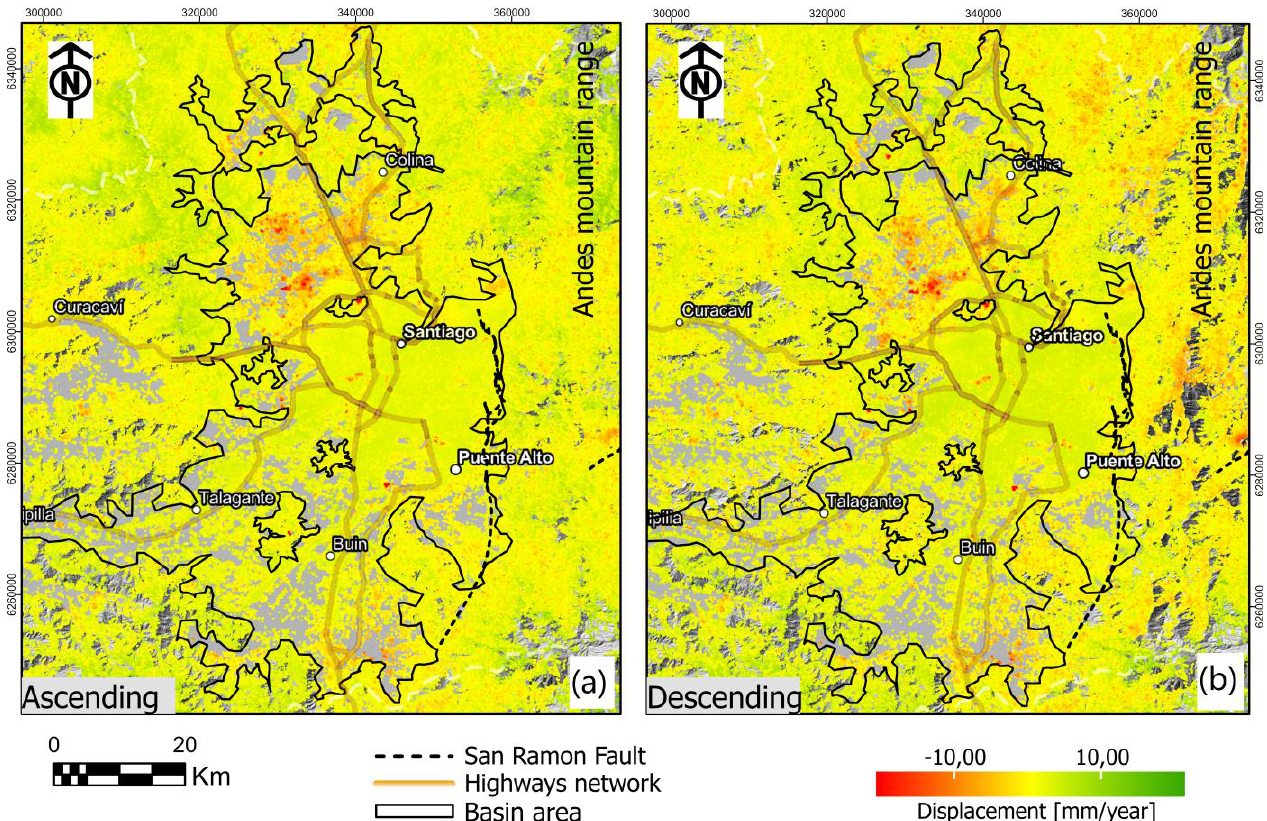
Figure 3. ( a ) LOS displacement maps for the study area, ( a ) Ascending orbits (A18), and ( b ) Descending orbits (D156), with ALOS DEM 30 mts used as background. Table 2. Basic PSI statistical comparison for ascending and descending orbits.